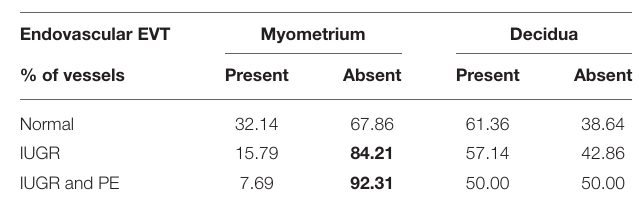
TABLE 6 | Endovascular EVT are absent in IUGR and IUGR and PE